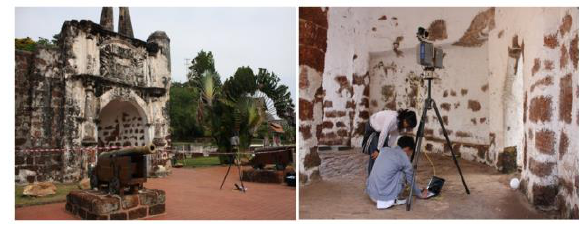
Figure 2. Scanning of A’Famosa fortress